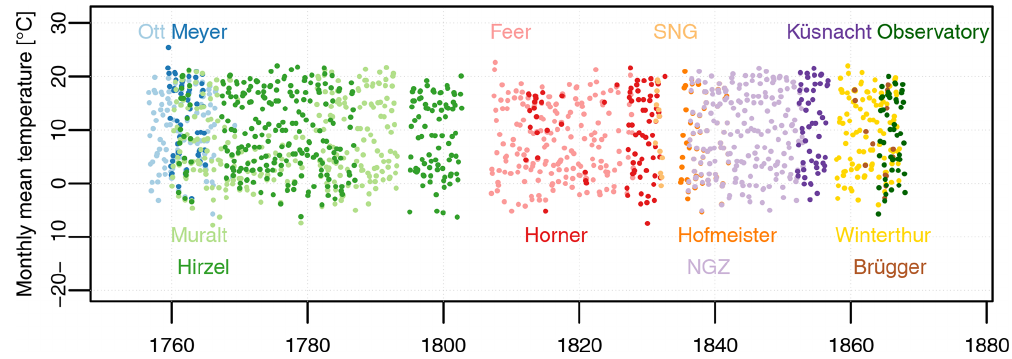
Figure 5. Monthly means of the raw data used to build the Zurich series with observers’ names or